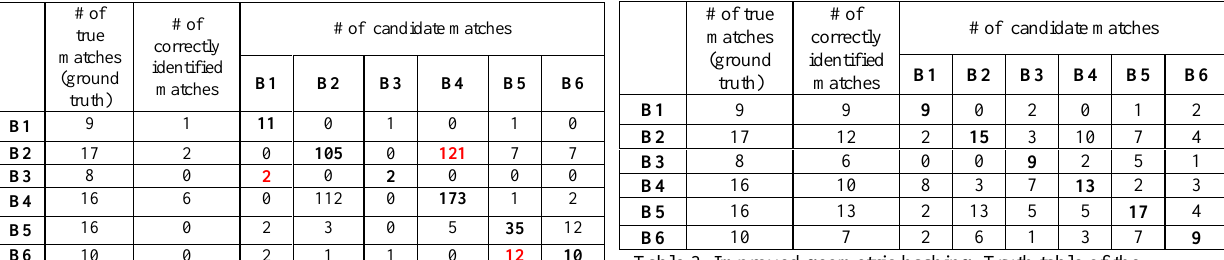
Table 2. Conventional geometric hashing: Truth table of the matching process.